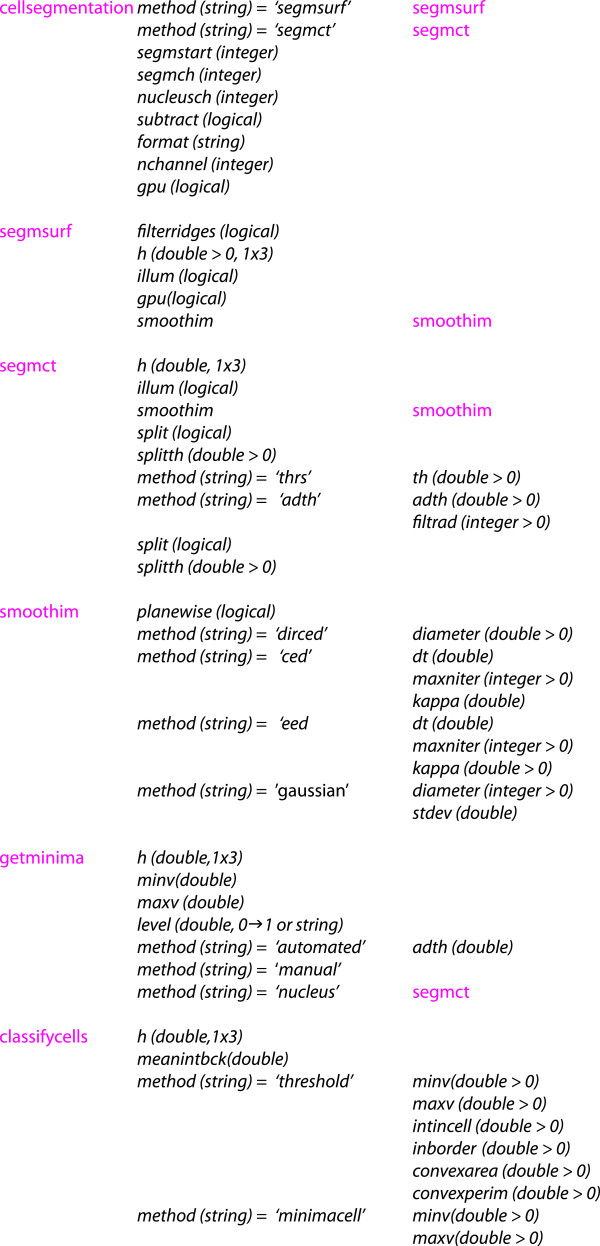
A selection of available subroutines (magenta) and parameter settings (italic) in CELLSEGM related to the struct prm. In brackets is the supported data type. For example, to set the threshold th in the nucleus method of segmsurf, with thresholding method thrs, follow the stream of methods segmsurf →getminima →nucleus →segmct →thrs, and assign it by prm.segmsurf.getminima.nucleus.thrs.th in the parameter file. On the other hand, if segmct is called upon from the command prompt, the same parameter setting is defined by prm.thrs.th.